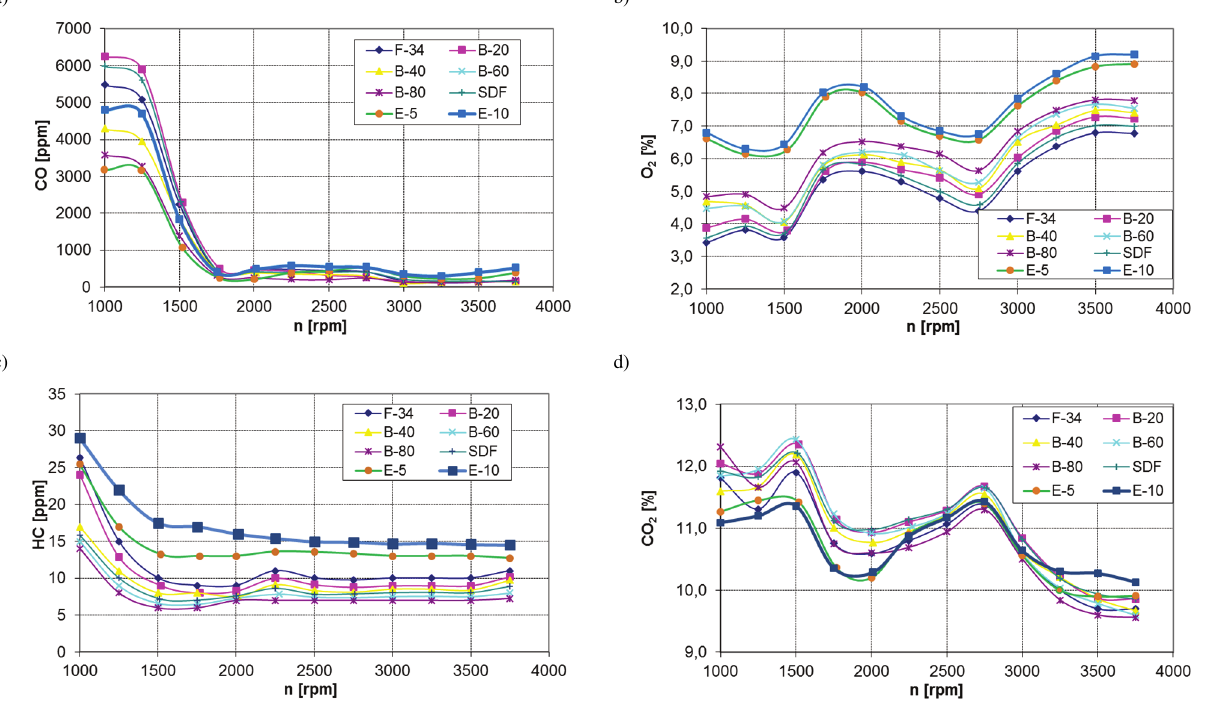
Fig. 4. External characteristic of the engine: a) concentration of carbon monoxide in exhaust, b) concentration of oxygen in exhaust, c) concentration of hydrocarbons in exhaust, d) concentration of carbon dioxide in exhaust